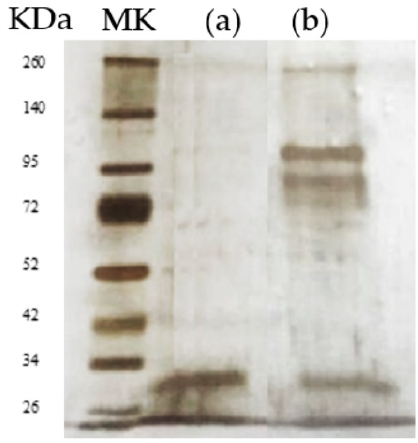
Figure 3. SDS Page of purified WA18 mycocin. MK marker; ( a ) purified fraction; ( b ) SP Sepharose- cation exchange chromatography active fractions.